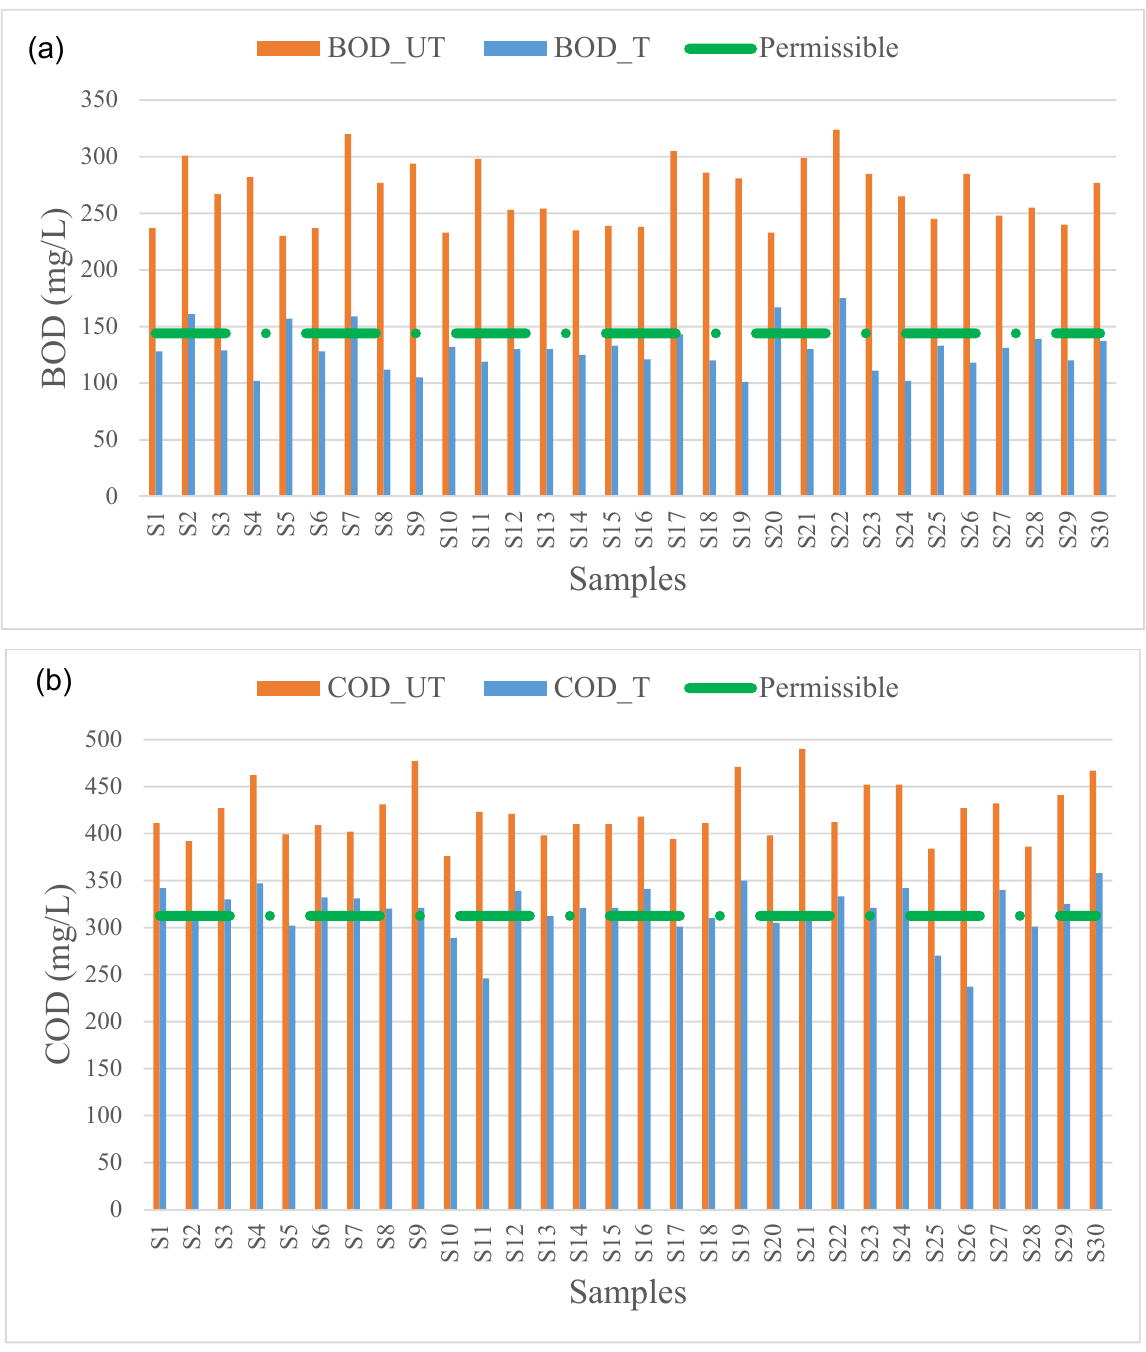
Figure 8. BOD ( a ) and COD ( b ) of untreated (UT) and treated (T) samples and permissible limits.